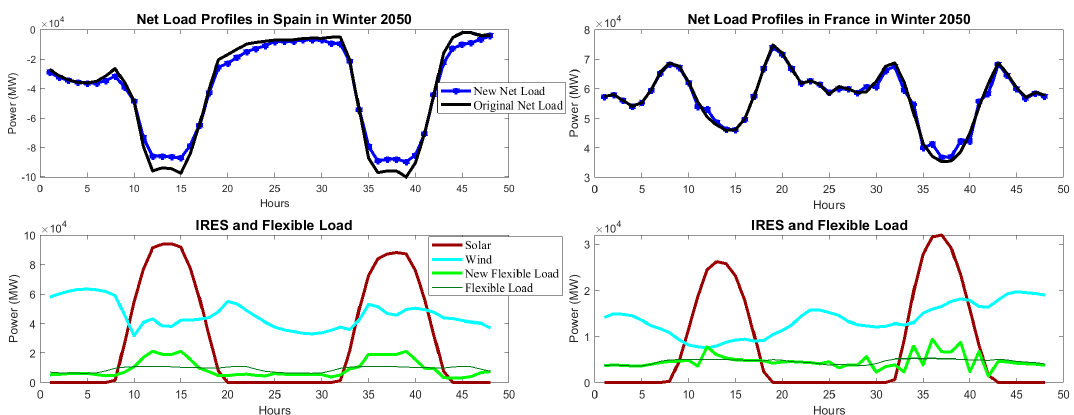
Figure 4. Sample load profiles in Spain and France in 2050. Net load refers to total load minus IRES production, the term ‘new’ to the profile with active DR, ‘new flexible load’ is the resulting load of all flexible groups and ‘flexible load’ is their potential load.